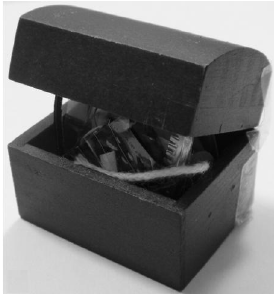
Figure 6. One of the samples used in the proof-of-concept